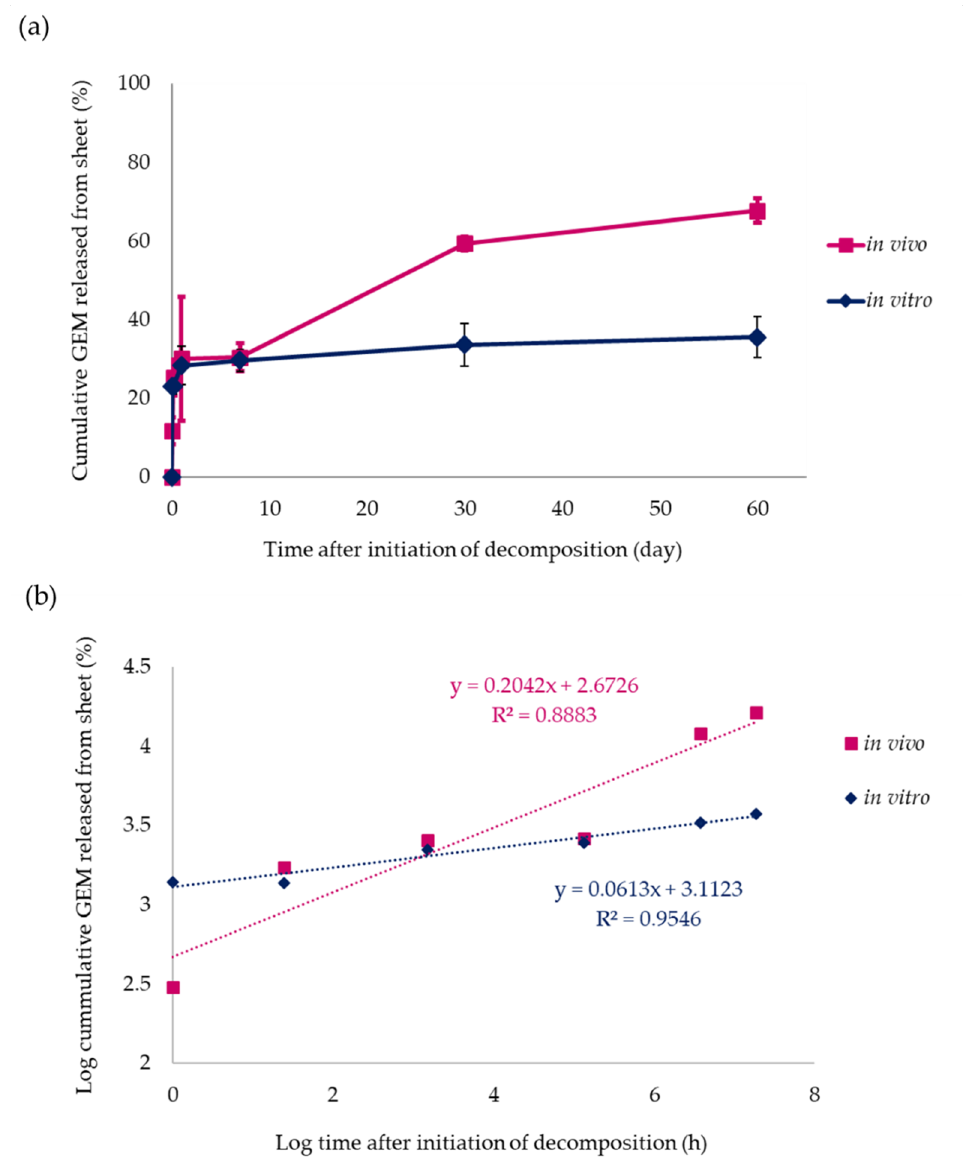
Figure 2. Percentage of GEM released from non-woven sheets with time in vitro and in vivo. ( a ) Cumulative release of GEM from 10 mg of 10 wt% GEM-containing non-woven sheets in vitro and in vivo was evaluated for a period of up to 60 d after non-woven sheet fabrication. After 60 d, 35.6 ± 2.1% and 67.8 ± 1.5% of GEM was cumulatively released in vitro and in vivo, respectively. ( b ) Korsmeyer–Peppas model: the approximate in vitro and in vivo expression levels are calculated as y = 0.0613x + 3.1123 (R 2 = 0.95) and y = 0.20427x + 2.6726 (R 2 = 0.89), respectively. Data are presented as the mean ± standard error of the mean (SEM).